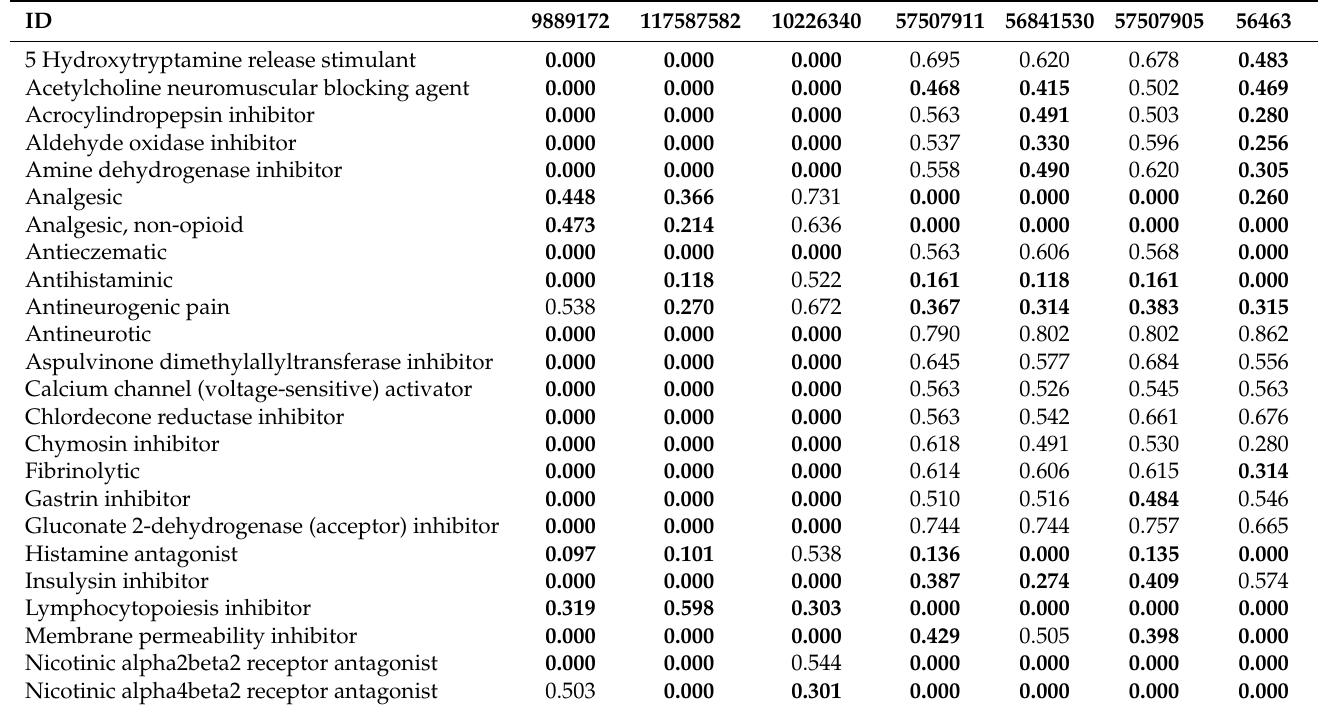
Table 9. The series of probabilities used to perform the Kruskal–Wallis test on Group 1. The bold numbers are probabilities less than